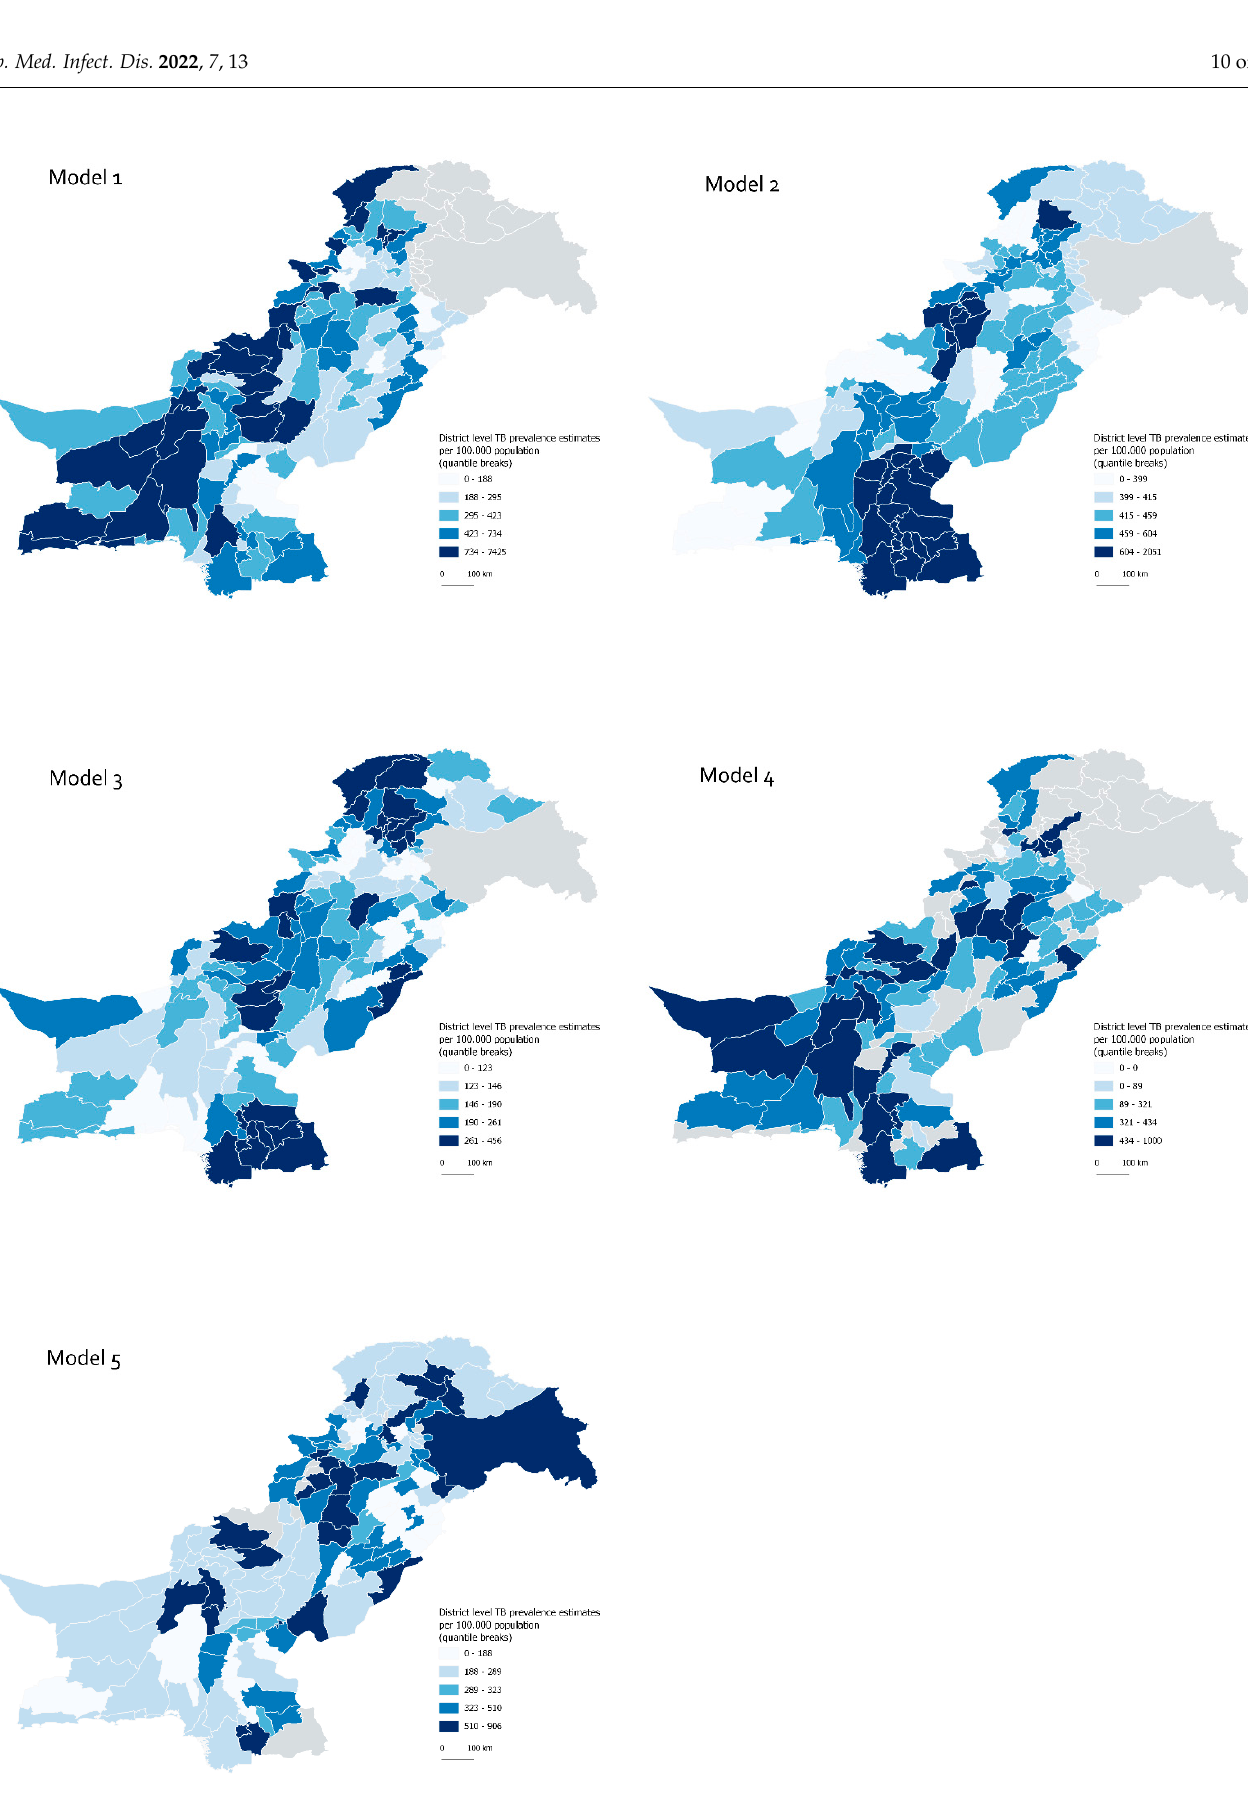
Figure 3. Ratio of 2018 new and relapse bacteriologically positive TB Notification rate over the predicted prevalence in each district, by